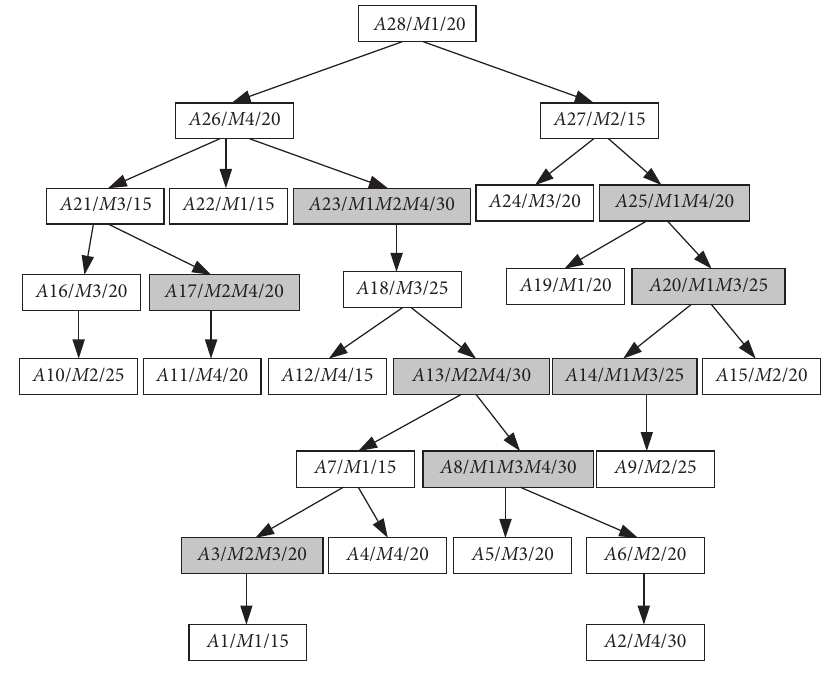
Figure 6: The reverse product processing tree. Table 1: The scheduling process of the algorithm scheduling product A in this